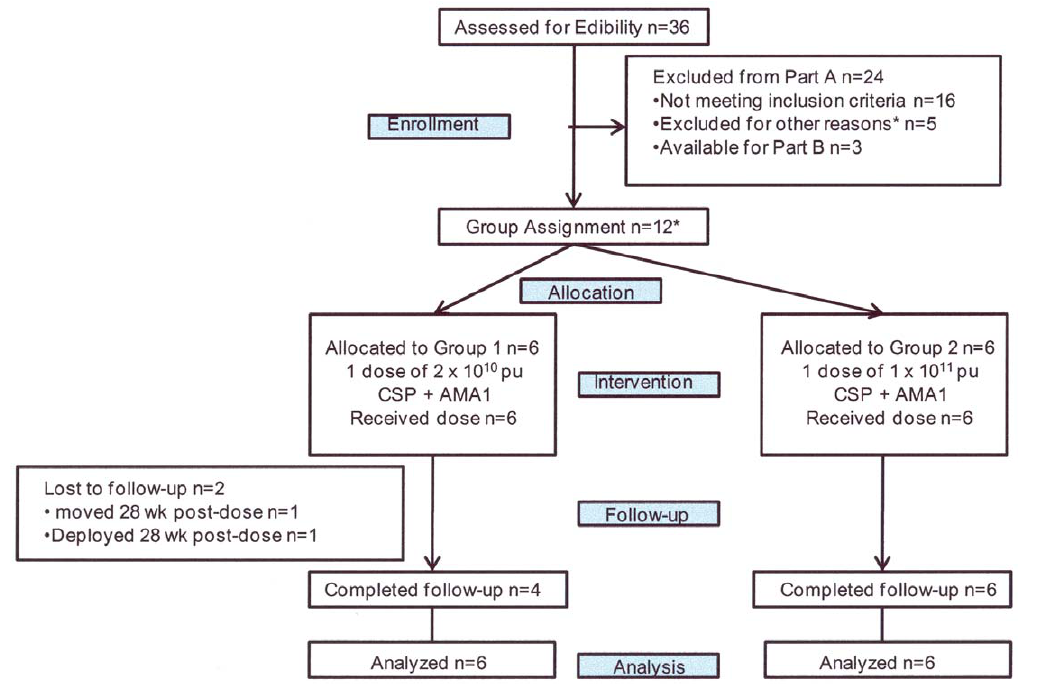
Figure 2. Flow diagram of volunteers in Groups 1 and 2. The first six volunteers were allocated to Group 1 and the subsequent six volunteers to Group 2. *Reasons for exclusion: lost to follow up (2), moved out of area (1), deployed (1), job commitments (1).